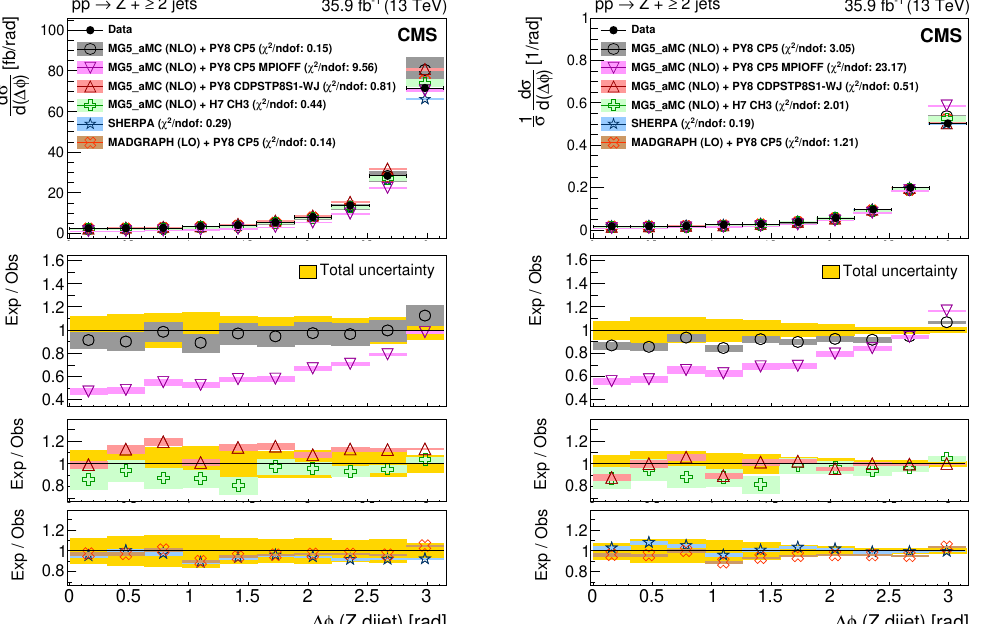
Figure 4 . Differential cross sections (left) and area-normalized distributions (right) as functions of ∆ φ between the Z boson and the dijet for Z + ≥ 2 jet events. The uncertainties in the predictions are shown as coloured bands around the theoretical predictions including statistical, PDF, scale and tune uncertainties for the NLO MG5_aMC + pythia 8 (with CP5 tune) and the statistical uncertainty only for the LO MG5_aMC + pythia 8 (with CP5 tune), NLO MG5_aMC + pythia 8 (with CDPSTP8S1-WJ tune, CP5 tune with MPI-OFF), NLO MG5_aMC + herwig 7 (with tune CH3), and sherpa predictions. In the top panel, the vertical bars on the data points represent statistical uncertainties, whereas in the bottom panels, the total uncertainty in data is indicated by the solid yellow band centred at 1. In the legend, the χ 2 per degree of freedom is given to quantify the goodness of fit of the model to the